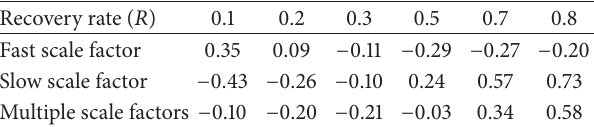
Table 1: Effect of the recovery rate.